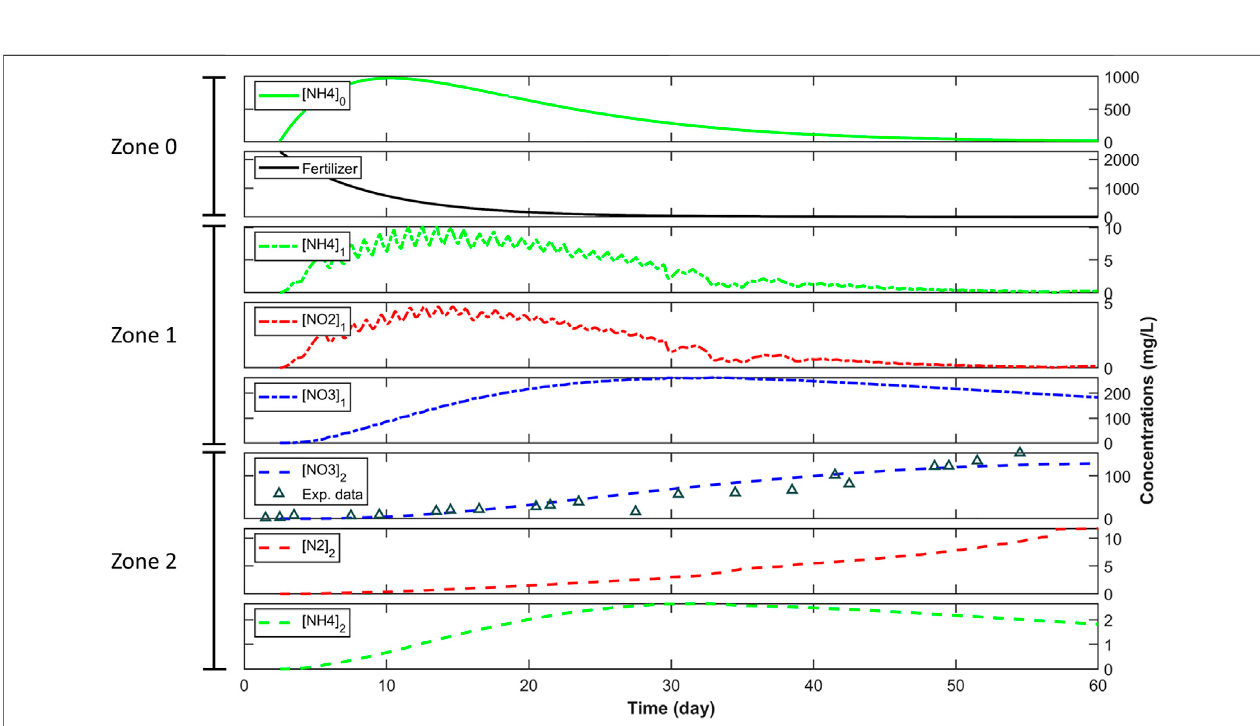
FIGURE 7 | Model fi t of reactions to the averaged NO 3 − concentrations measured in the fertilized soil columns ( R 2 = 0.88) and simulation of other nitrogen transformationprocessesinthreezones0,1,and2usedforthesimpleplug fl owreactormodel.Alistofparametersandtheirestimatedvaluesarepresentedin Table2 .